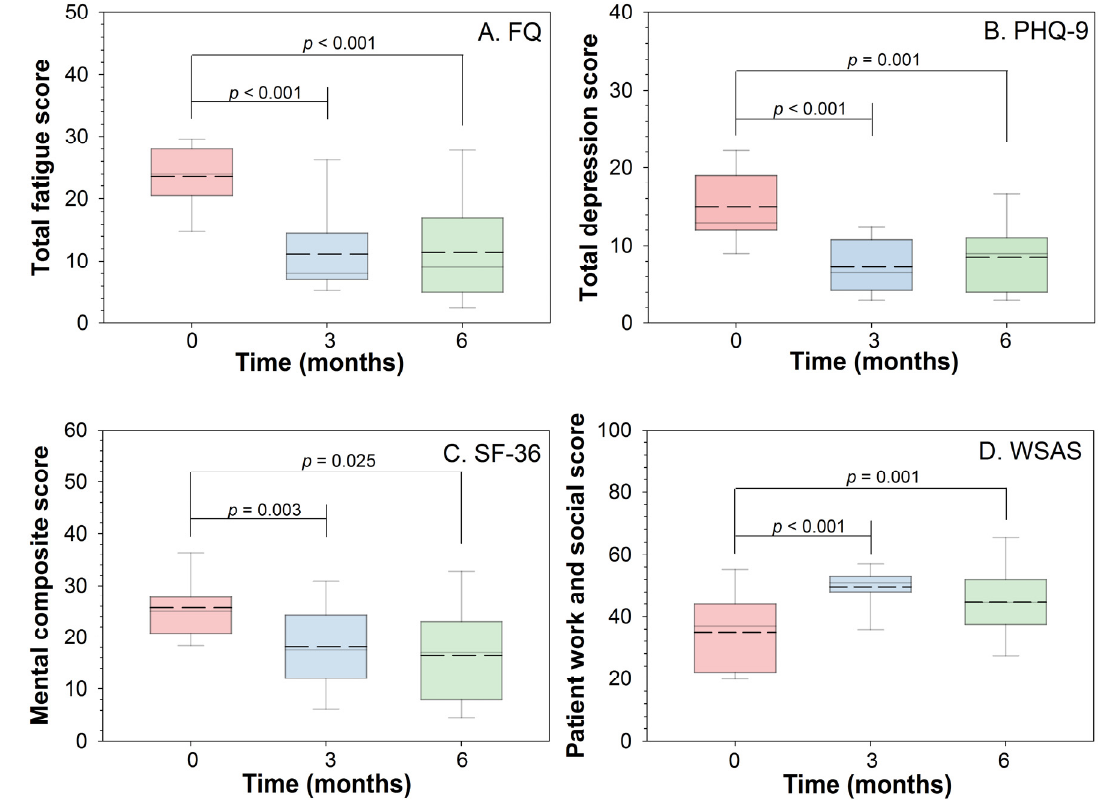
Figure 2. Patient-reported outcome measures. ( A ) Fatigue Questionnaire (FQ); ( B ) Patient Health Questionnaire 9 (PHQ-9); ( C ) Short-Form Health Survey 36 (SF-36); ( D ) Work and Social Adjustment Scale (WSAS). The bottom of the box represents the 25th percentile, the dashed line represents the mean, the solid line represents the median, the top of the box represents the 75th percentile, and the whiskers represent the 5th and 95th